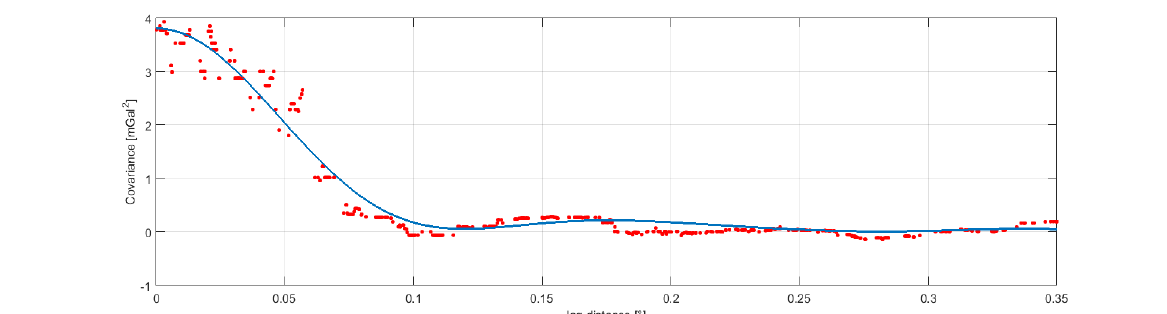
Figure 4. Empirical covariance retrieved from the CarbonNet dataset by means of the crossover analysis (red points), and theoretical covariance used to simulate data (light blue solid